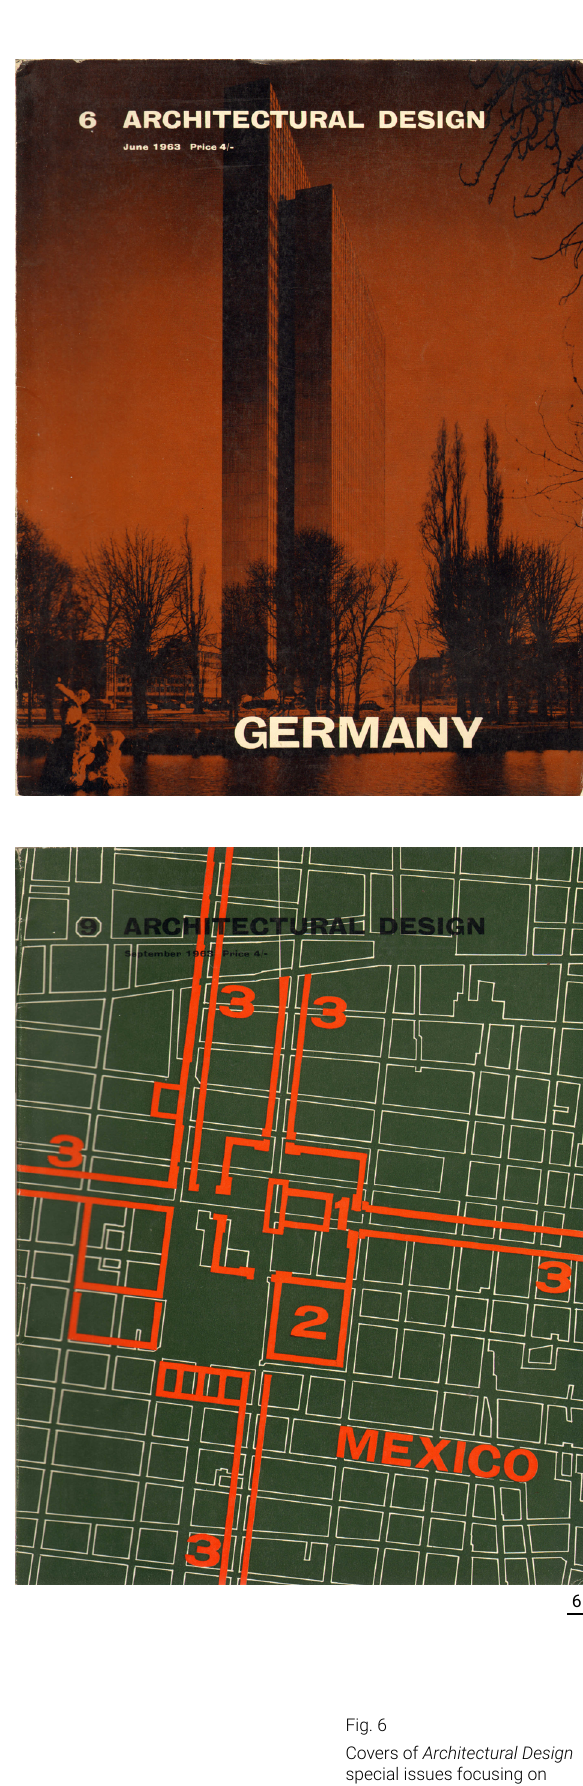
Covers of Architectural Design special issues focusing on France,Germany and Mexico (April, June and September